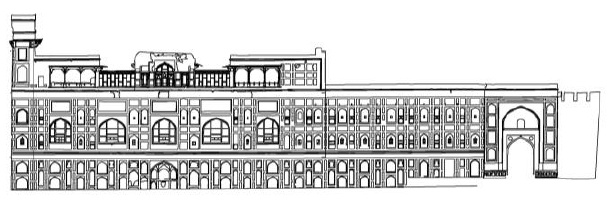
Figure 4. EDM survey of the Picture